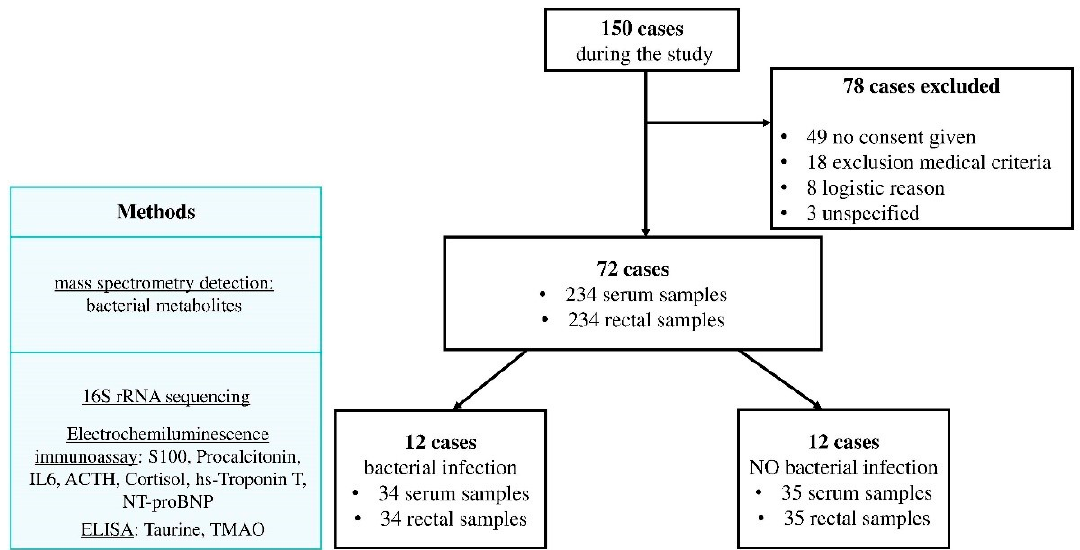
Figure 1. The study design. Of the 72 patients included in the study, complications developed in 12 cases. For comparison, a group of patients without complications was selected, comparable in the number of patients, age, severity of surgery and duration of the extracorporeal circulation.